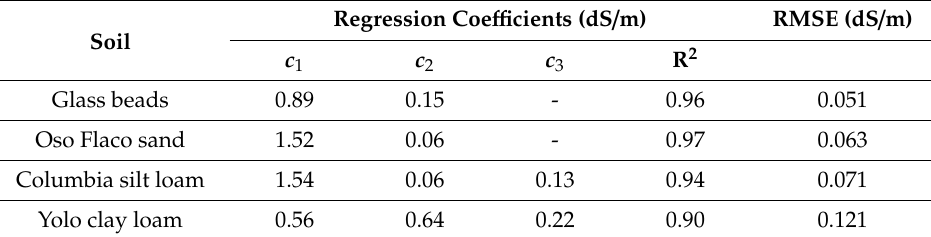
Table 5. Optimized parameters for Rhoades model for all soils.